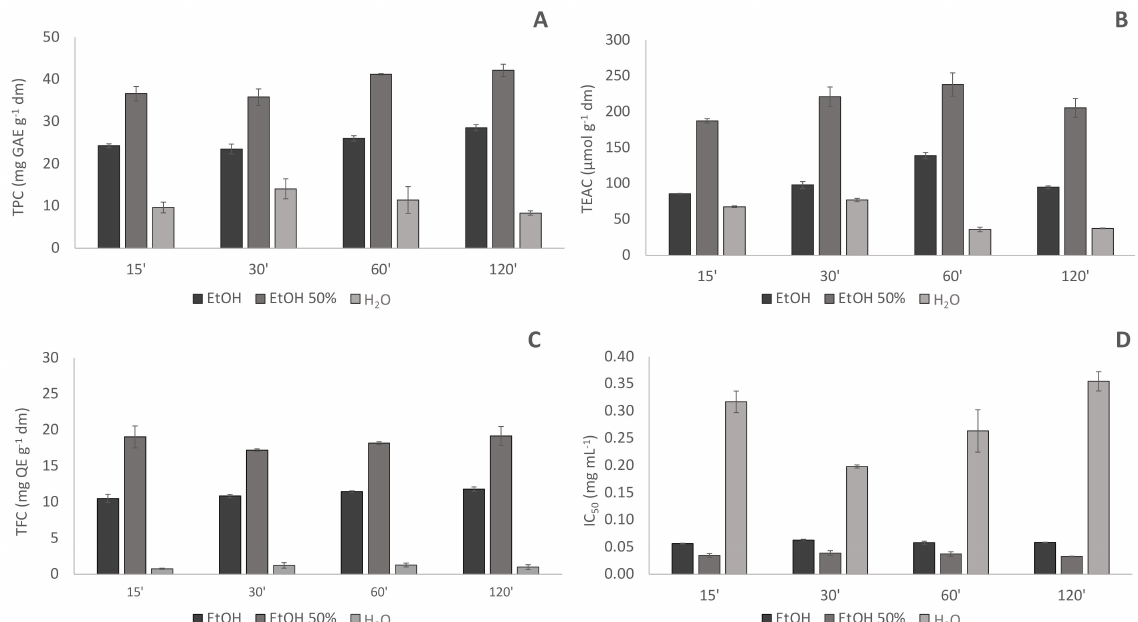
Figure 2. Comparison of phenolic content and antioxidant capacity of pure ethanol (EtOH); water (H 2 O) and ethanol water 50:50 ( v / v ) (EtOH 50%) hop extracts obtained by high power ultrasounds (HPUS); ( A ) TPC: Total Phenolic Content (mg GAE g − 1 dm); ( B ) TEAC: Trolox Equivalent Antioxidant Capacity ( µ mol g − 1 dm); ( C ) TFC Total Flavonoids Content (mg QE g − 1 dm); ( D ) antiradical capacity express as Inhibitory Capacity IC50 (mg mL − 1 ); 15 (cid:48) , 30 (cid:48) , 60 (cid:48) , 120 (cid:48) : extraction times in